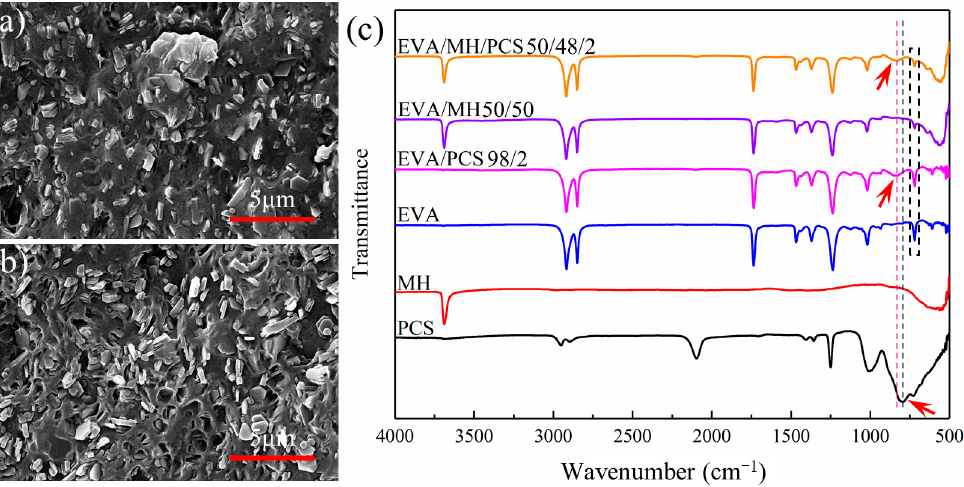
Figure 1. The SEM images of ( a ) EVA/MH 50/50 and ( b ) EVA/MH/PCS 50/48/2; ( c ) the FTIR spectra of the composites.